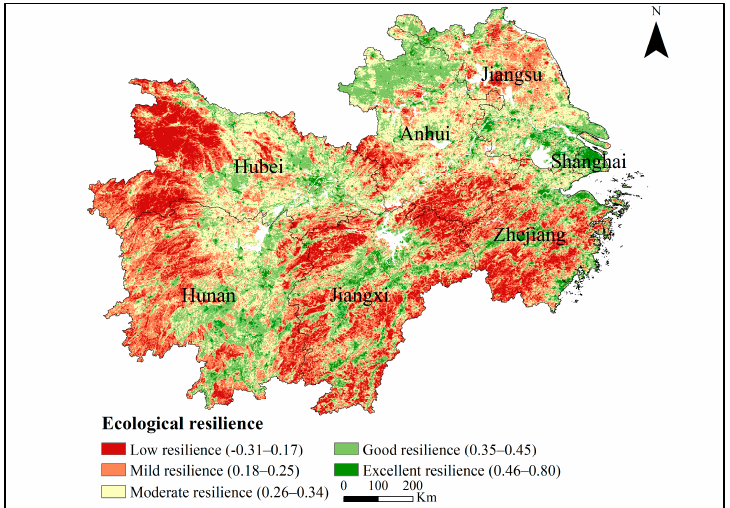
Figure 5. Spatial pattern of ecological resilience in the YREBML during 2000–2020. Note: Datum: D_WGS_1984; Projection: WGS_1984_UTM_Zone_50N; Representation scale: 1:7,000,000; Nominal scale: 1:100.